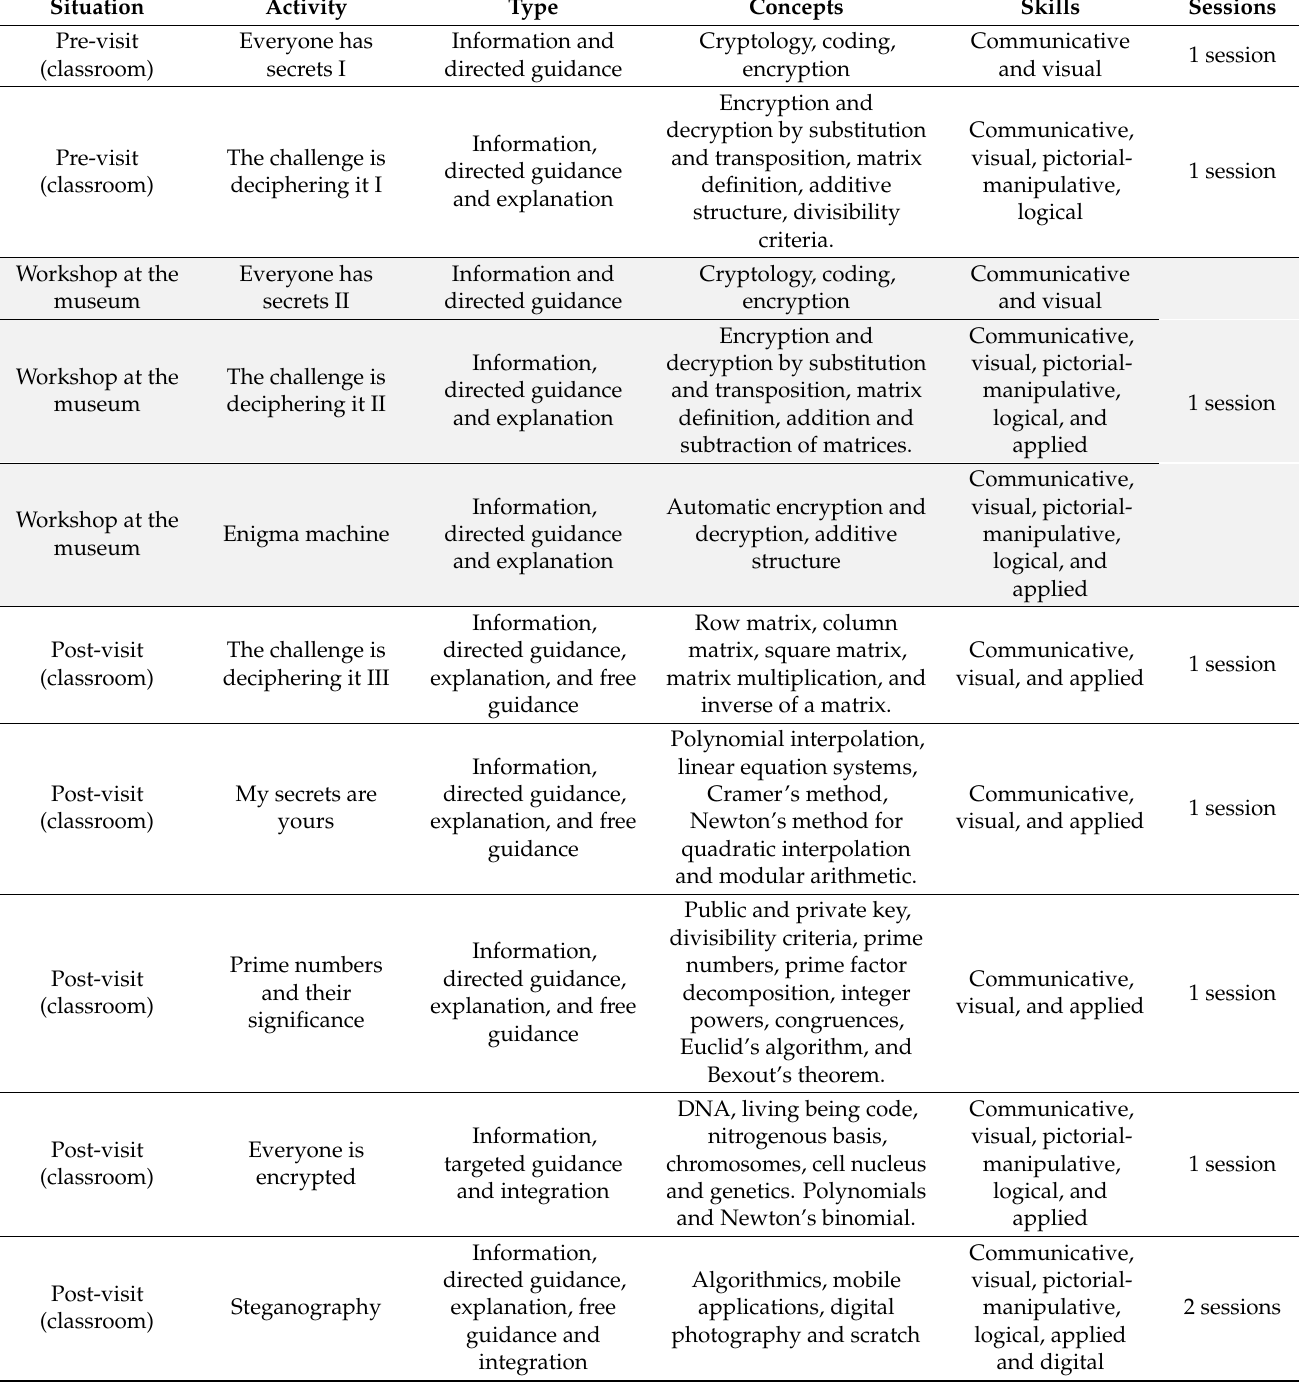
Table 3. Characteristics of the STEAM